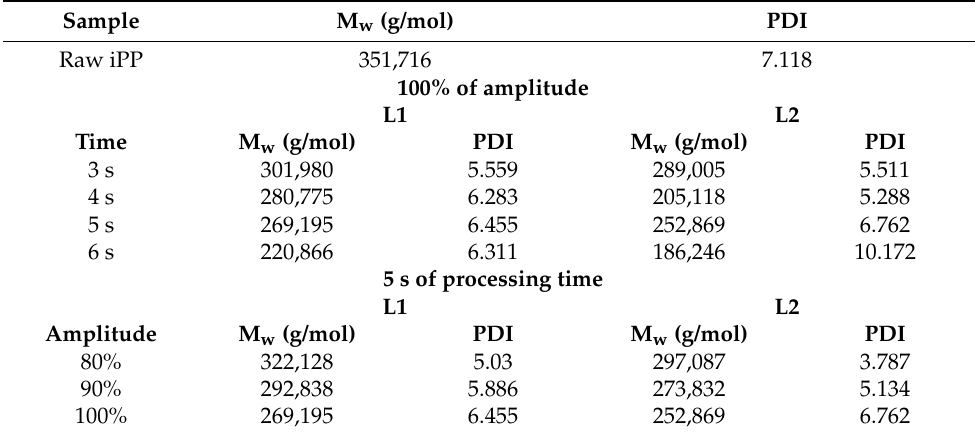
Figure 3. Graphs from GPC to assess the changes in the molecular weight after the UMIM process. On the left, the comparison for different times at the same amplitude (100%). On the right, the comparison for different amplitude at the same time (5 s). L1 corresponds to the side of the specimen closer to the sonotrode, and L2 corresponds to the opposite side. Table 1. Molecular weight (M w ) and polydispersity index (PDI) of samples fabricated by UMIM. PDI is calculated as M w /M n .